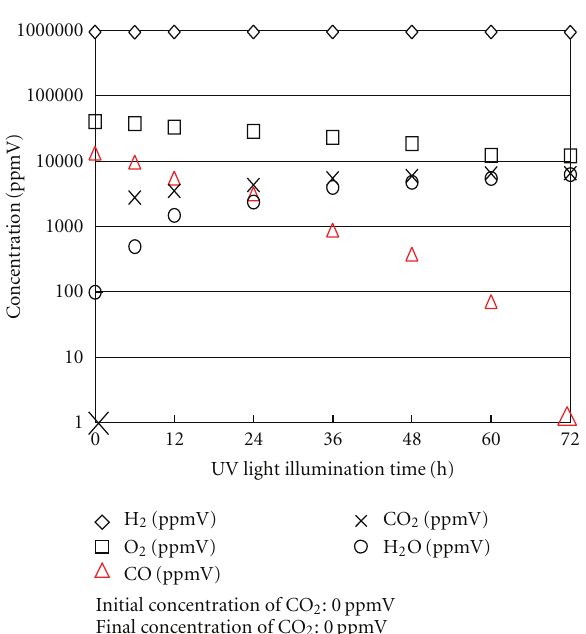
Figure 13: Change of each gas concentration with UV light illumination time in the long time experiment (loading ratio of TiO 2 of 20 wt%, initial concentrations of O 2 of